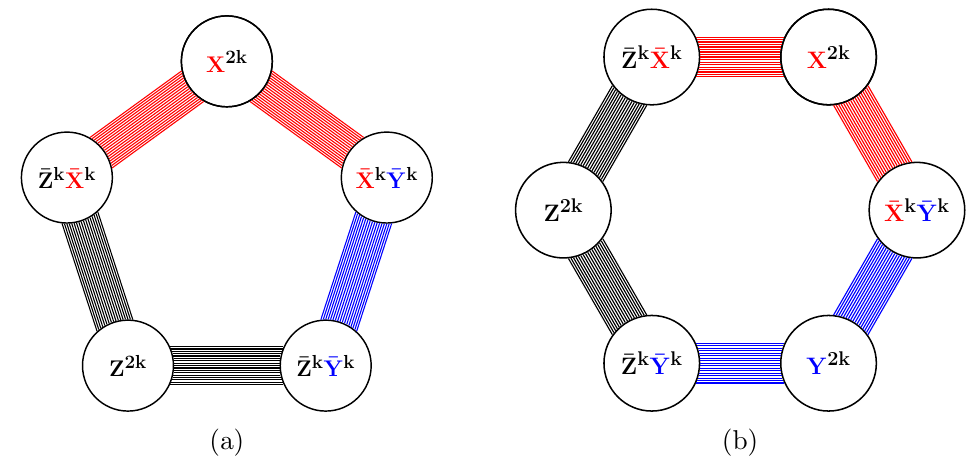
Figure 11 . Polarized (a) (cid:12)ve-point and (b) six-point